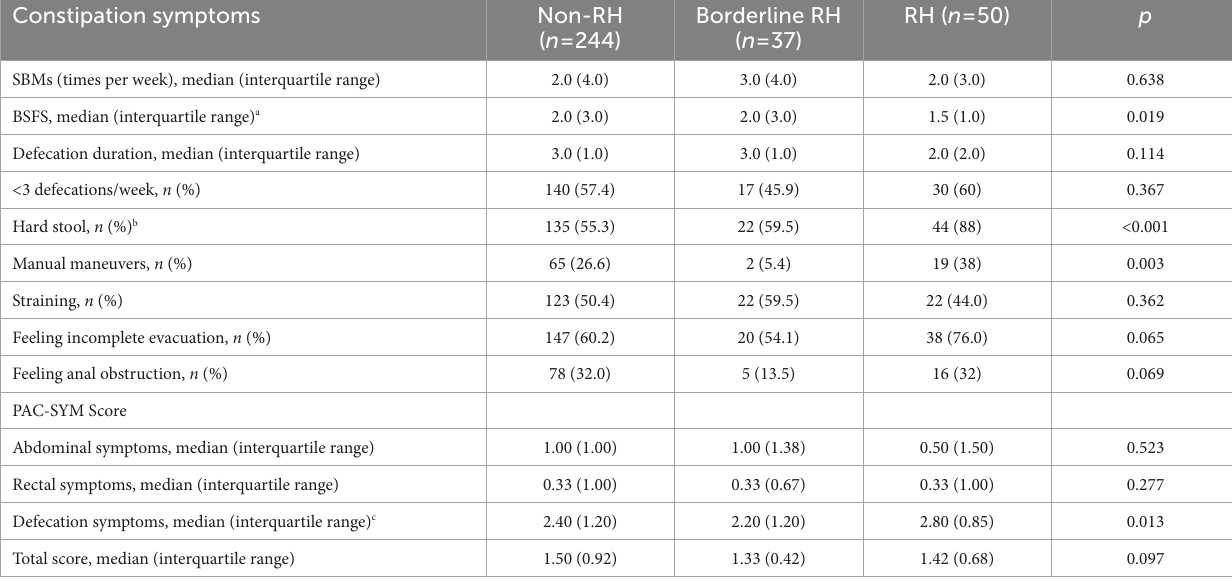
TABLE 5 Constipation symptoms and defecation characteristics of 311 patients with FDD in 3 groups. Constipation symptoms